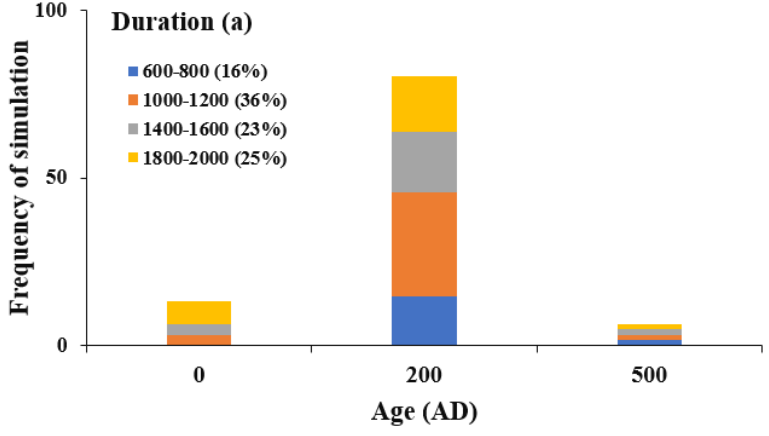
Figure 14. Histograms of the 4% best mean of sedimentation models (n = 326) based on the ME for floodplain sedimentation of Chencha.